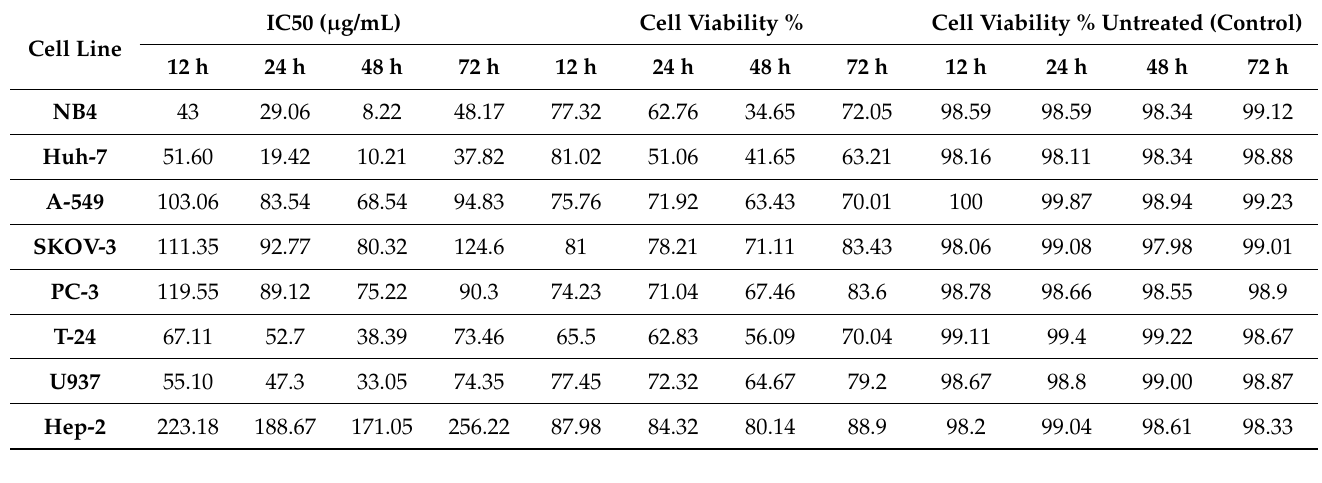
Table 3 and Figure 3 show the inhibitory impact of P. amygdalus var . amara on right cancer cell lines at several concentrations (5–300 µg/mL). Table 3. Anti-cancer impacts of P. amygdalus var . amara alcoholic seed extractions.